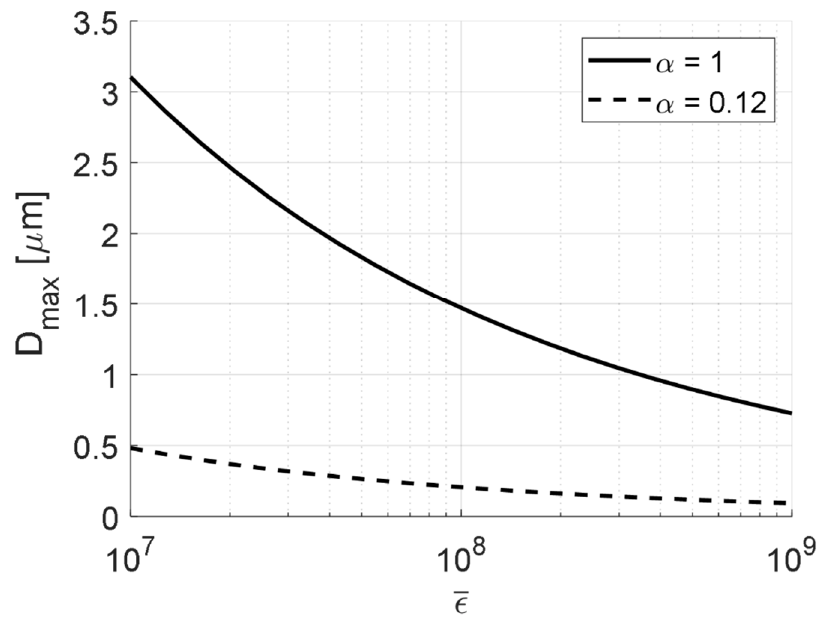
Figure 7. Prediction of maximum drop diameter, D max , for the case of a highly viscous drop in water as a function of time-averaged dissipation rate of TKE, ε . Predictions are shown for the traditional Kolmogorov–Hinze framework neglecting stochastic time-variations in turbulent stresses ( α = 1, Figure 4) and for the multifractal correction (Equation (21 ) ), for exceedingly long processing times ( α = 0.12).